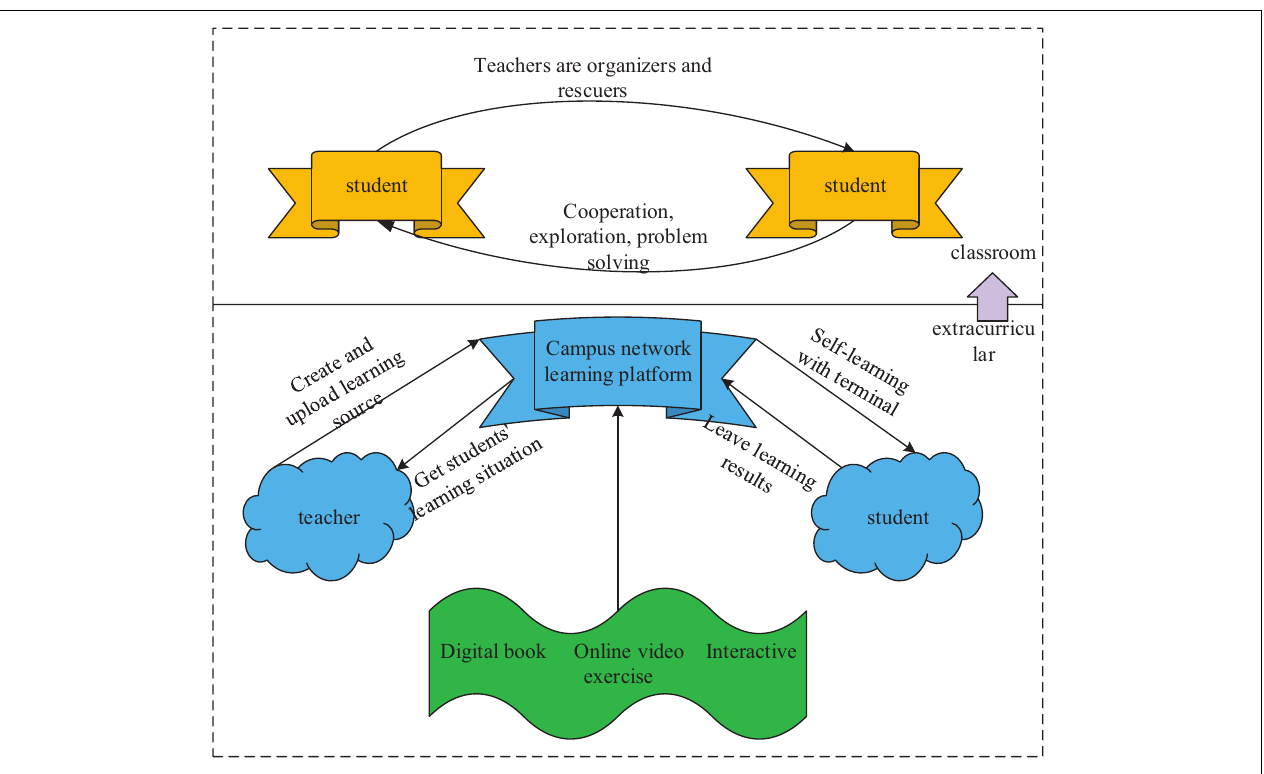
FIGURE 1 | Practice of the flipped classroom.